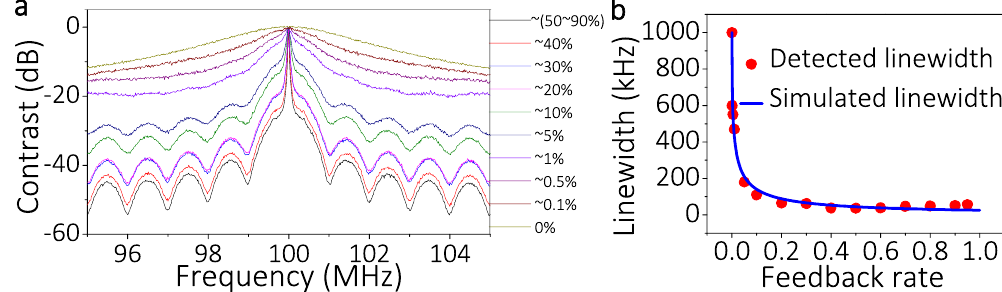
Figure 2. ( a ) Normalized power spectrum for different feedback rate (Re). ( b ) Corresponding fitting linewidth (red point) from ( a ) and the simulated linewidth for different feedback rate (Re) (blue curve) with Δ f 0 = 1 MHz, τ = 0.0534 ns, α = 5, γ = 0.0008 (~31 dB isolation of DFB isolator), R in L = 10.7 m, ε = 1.